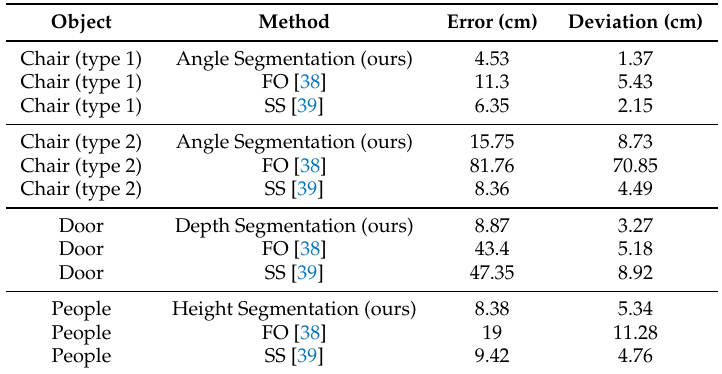
Table 5. Average error distance between the actual position of the detected objects and their estimated positions in the map. People were static and 20 repetitions were run for each